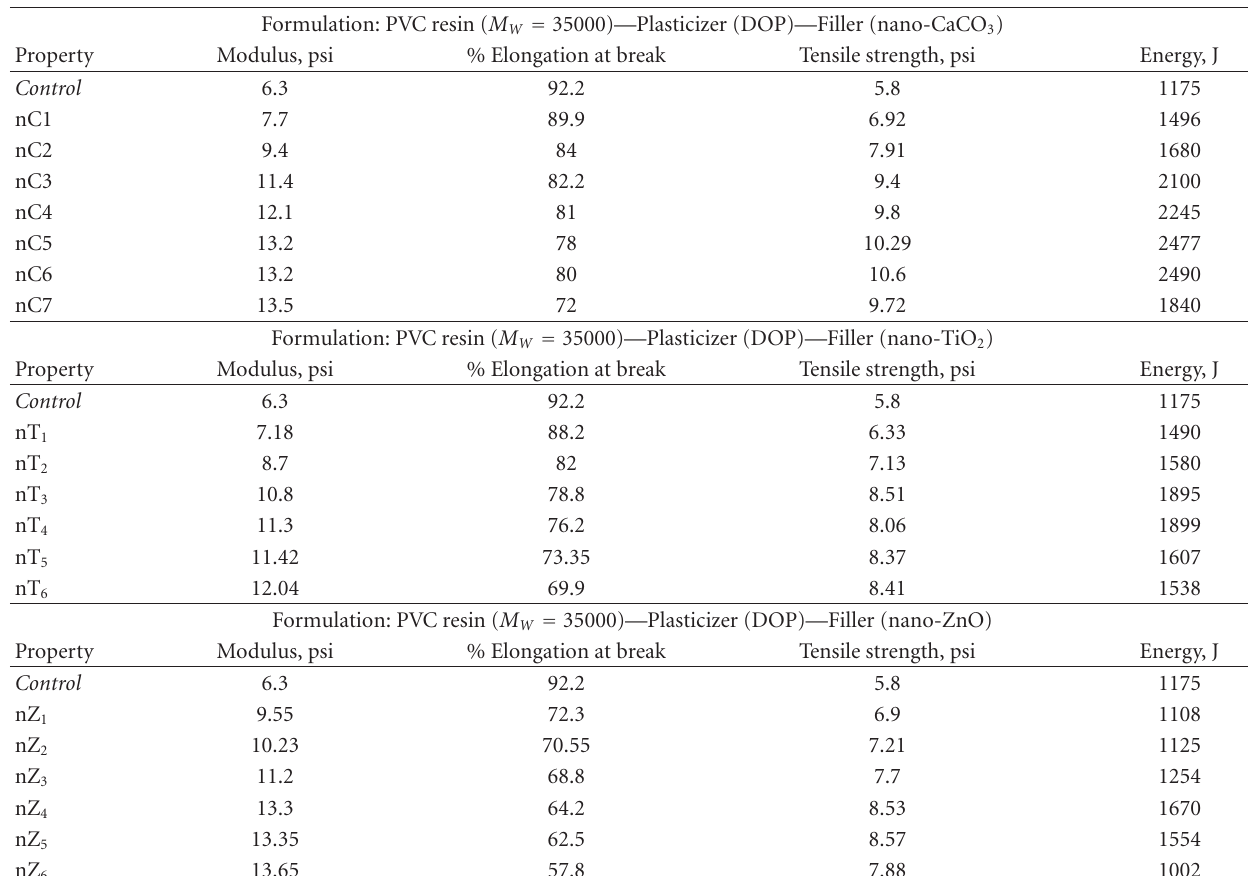
Table 3: Mechanical properties of prepared nanocomposites.